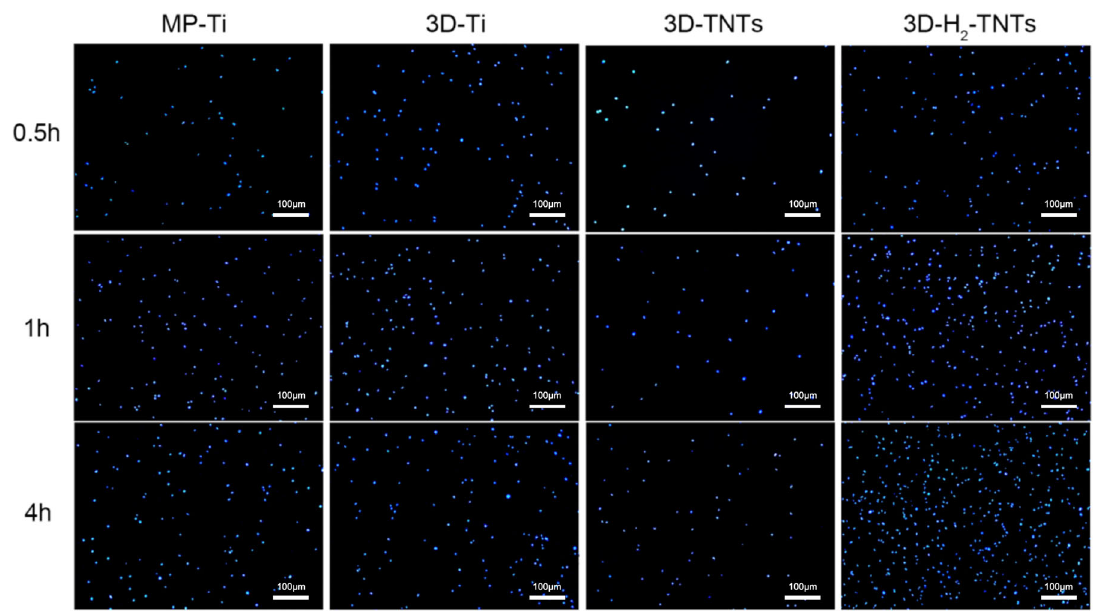
Fig. 6 Cell adhesion and proliferation assays by CCK-8. a HGFs adhesion assays on the samples after incubation for 0.5 h, 1 h and 4 h (* p < 0.05 when compared with the other groups). b HGFs proliferation assays on the samples after incubation for 1 day, 3 days, 5 days and 7 days (* p < 0.05 when compared with the other groups)